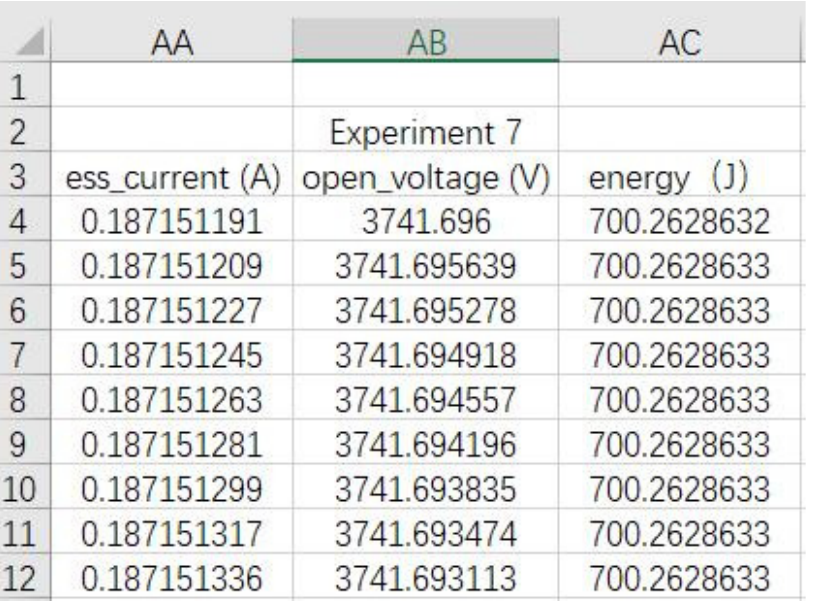
Figure 18. Secondary development diagram of battery model.